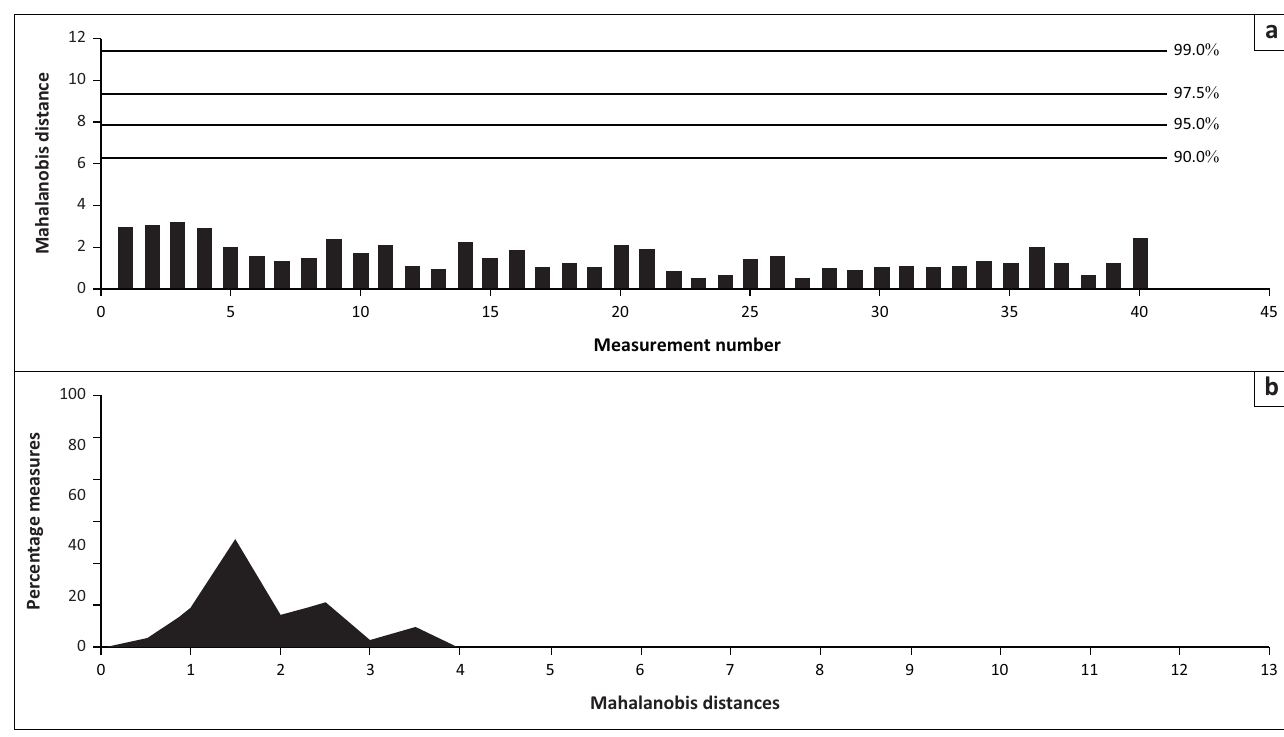
FIGURE 5: The Mahalanobis distances for central corneal power measurements. 41 None of the 40 measurements for a single eye reach the critical distance (or percentage) that would imply possible outliers ( ≤ 90 % ).